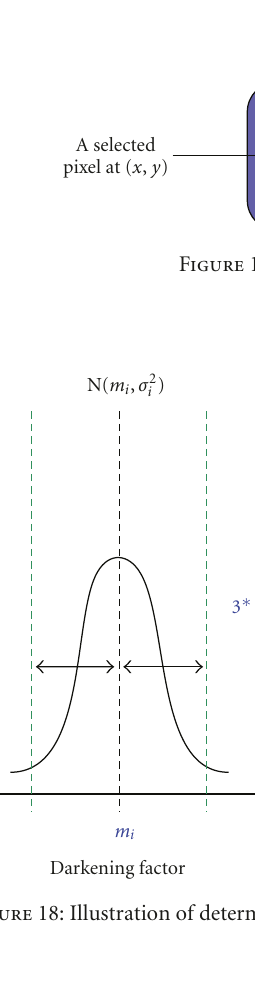
Figure 16: The selected pixels for Gaussian model updating.